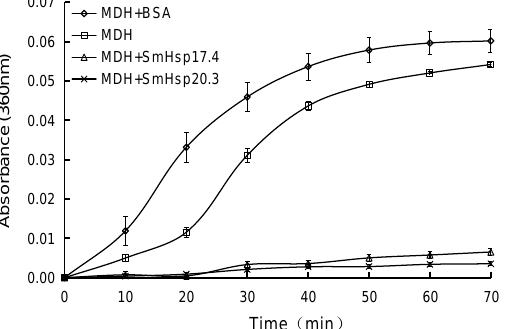
Figure 9. Molecular chaperone activity of SmHsp17.4 and SmHsp20.3. To perform mitochondrial malate dehydrogenase (MDH) thermal aggregation assays, MDH (0.5 μM) was incubated at 43˚C in the absence and in the presence of SmHsp17.4, SmHsp20.3, or bovine serum albumin (BSA, control) in a molar ratio 1:1. Aggregation of MDH was reflected by the absorbance at 360 nm. Data were obtained from three independent experiments and were shown as the means ± SE.